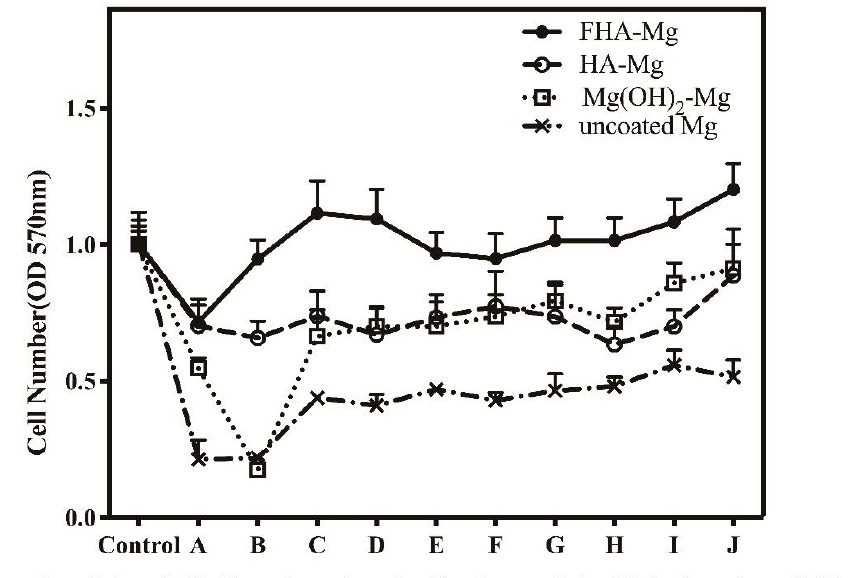
Figure 3. Relative cell number measured by 3-(4,5-dimethylthiazol-2-yl)-2,5-diphenyltetrazolium bromide (MTT) assay for hMSCs cultured in conditioned media collected at different time points from uncoated Mg, Mg(OH) 2 -Mg, HA-Mg, and FHA-Mg scaffolds. Values shown are mean ± standard error ( n =